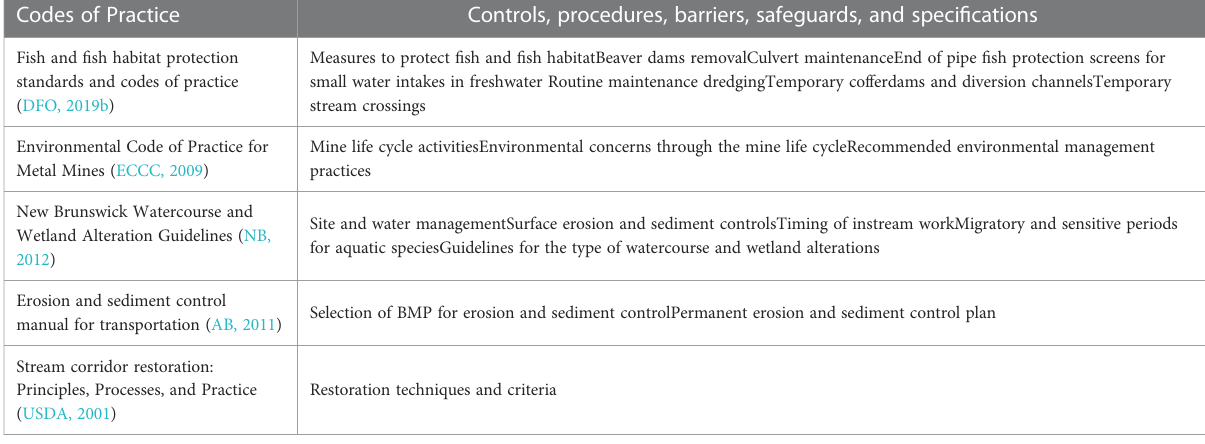
TABLE 3 Examples of technical measures from codes of practice (USDA, 2001; ECCC, 2009; AB, 2011; NB, 2012; DFO, 2019b). Codes of